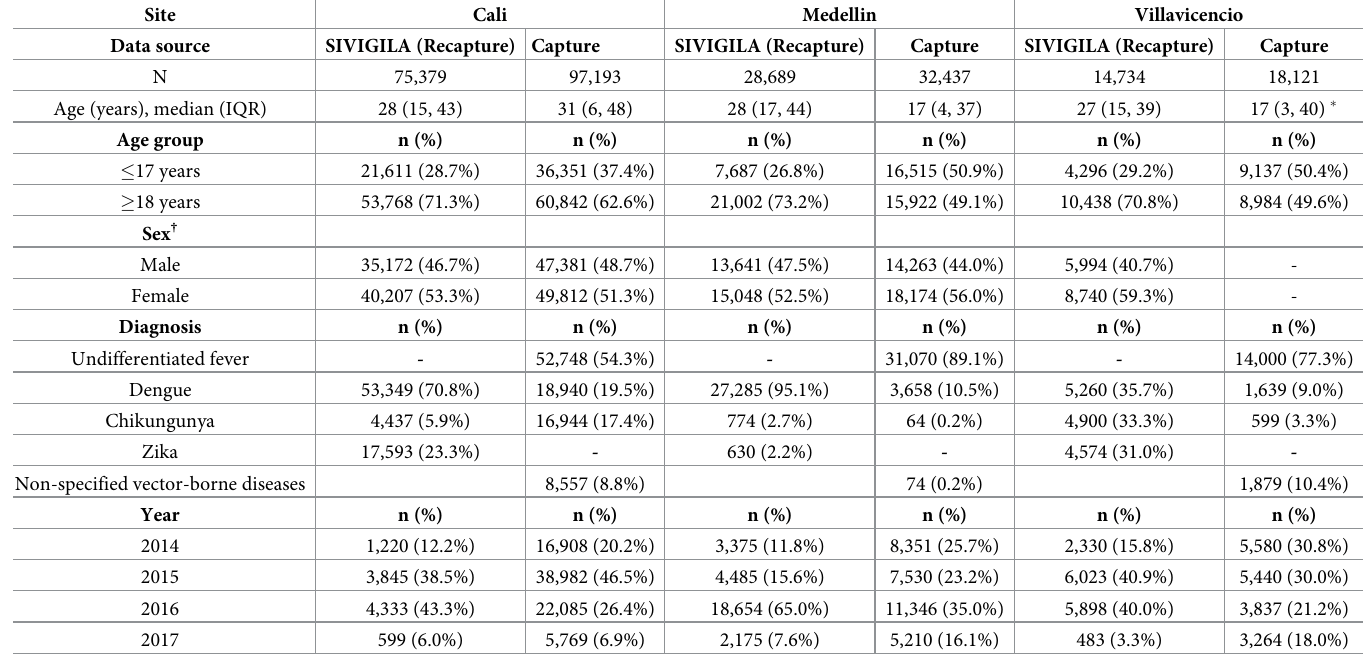
Table 1. Descriptive characteristics of arboviral cases reported by data source in Cali, Medellin, and Villavicencio (Colombia), 2014–2017. Site